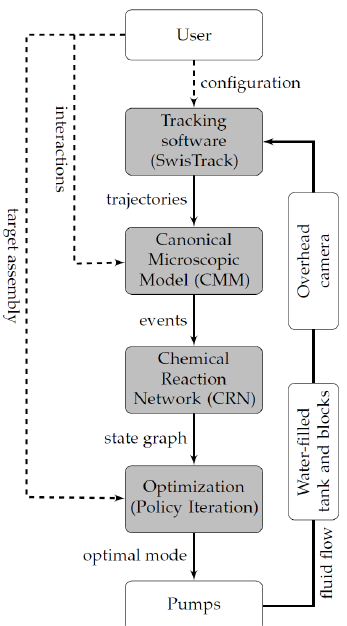
Figure 4. Overview of the M 3 framework as deployed in this study and the different types of information flowing between its constitutive modules [9]. Gray-shaded nodes are computational entities, whereas other nodes are physical entities. Dashed arrows denote flows that are not automated, but need to be performed only once prior to the experiment. Note that the closed-loop control is completely